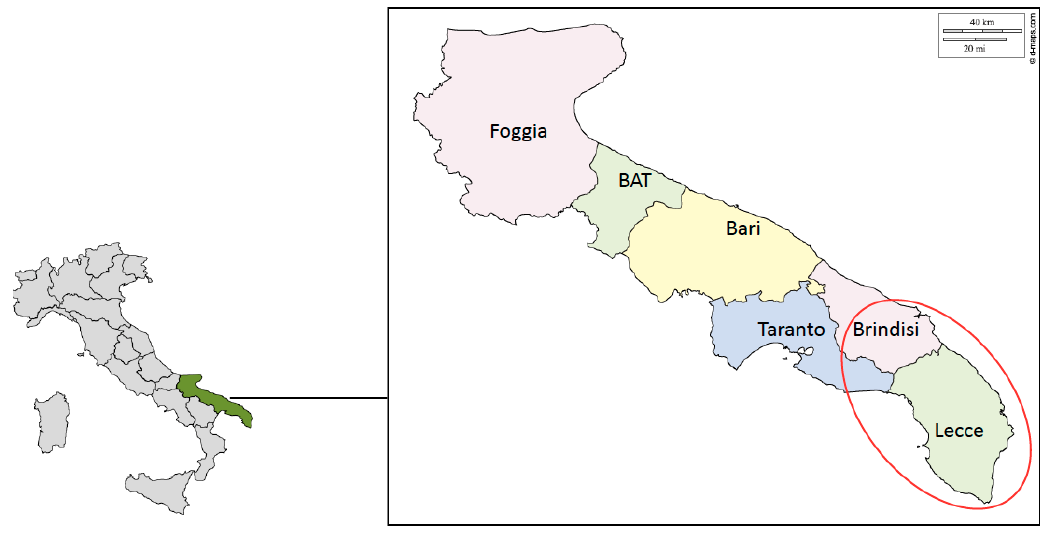
Figure 2. Geographical position of the study area. Source: author.